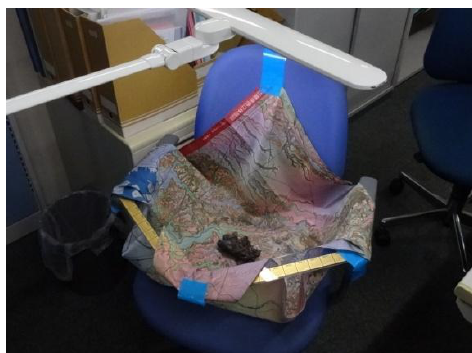
Figure 4. Image capturing stage